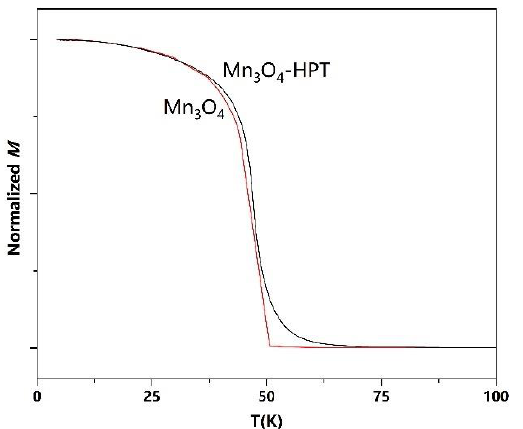
Figure 5. The M-T curves of the Mn 3 O 4 precursor and Mn 3 O 4 after HPT, respectively. The magnetic hysteresis loops (M-H) of the Mn 3 O 4 precursor and the severely de- formed Mn 3 O 4 were measured at 5 K, as shown in Figure 6. It should be noted that the M- H curves were measured after field cooling from room temperature. The coercivity of the undeformed Mn 3 O 4 and the Mn 3 O 4 after HPT for 3 turns at 5 K is 0.498 T and 1.007 T, grain size refinement of the Mn 3 O 4 during severe deformation. The coercivity of the bulk HPT Mn 3 O 4 is similar to that of the 1.05 T coercivity of the Mn 3 O 4 nanoparticles prepared by laser ablation method [73].